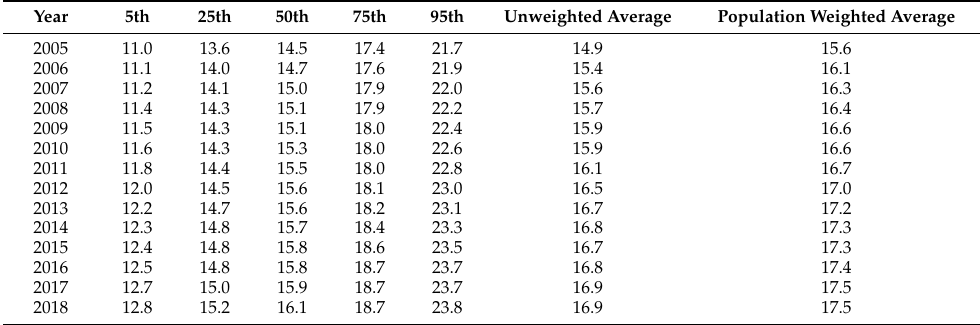
Table 3. Selected percentiles of NO 2 concentrations (ppb) predicted for 358 township-level divisions in Ningxia Province